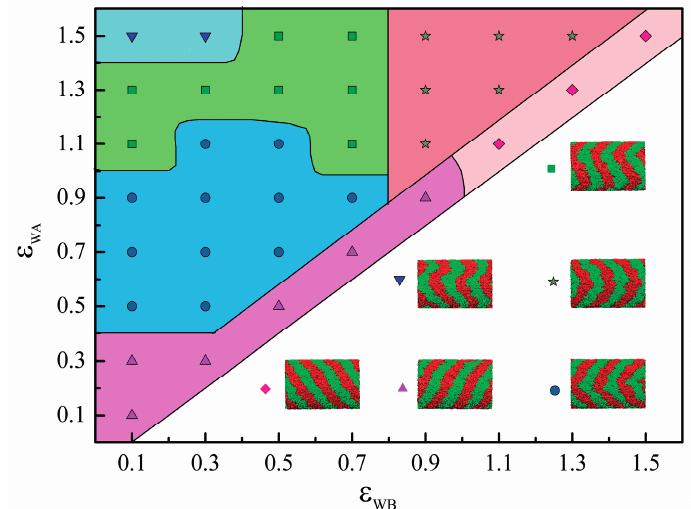
Figure 2. Phase diagram of copolymers under the confinement of a multi-walled nanotube system. Morphologies are organized as a function of surface preferences